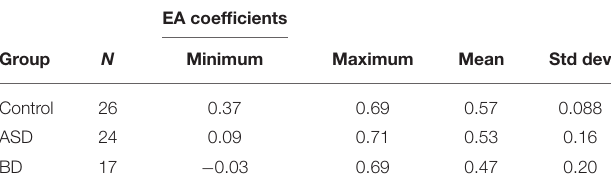
TABLE 5 | Descriptive statistics for the videos selected for the development of the EA task-short